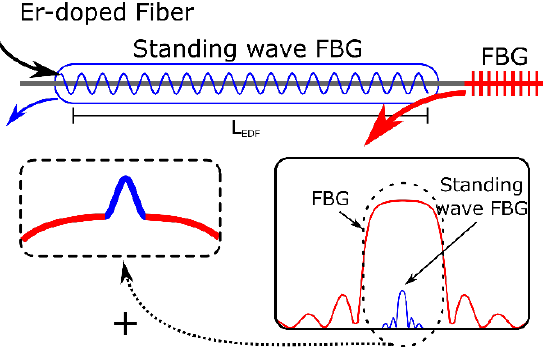
Figure 2. The FBG induced by the standing wave in the unpumped Er-doped fiber (EDF) modifies the passive response of the mirror FBG. Part of the incoming light is reflected by the induced FBG and dominates the active medium lasing properties due to gain competition of EDFs.